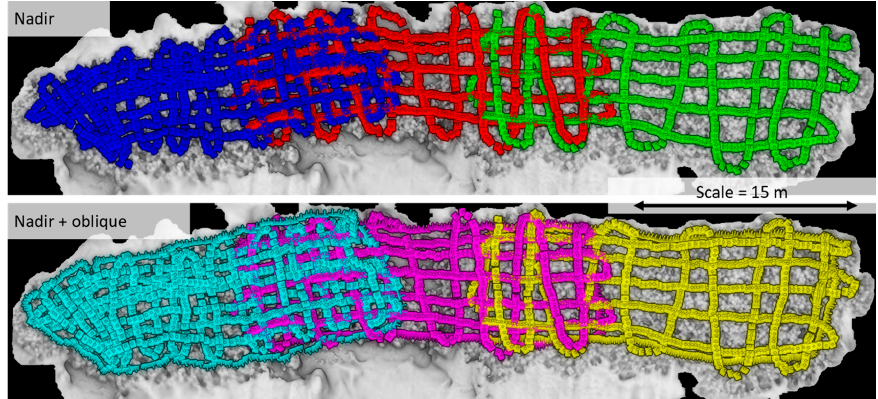
Figure 13. The two different imaging configurations over the 50 × 10 m fore reef plot. The oblique images are visible all around the plot. The different colors indicate the three different dives required to complete the photogrammetric acquisition.